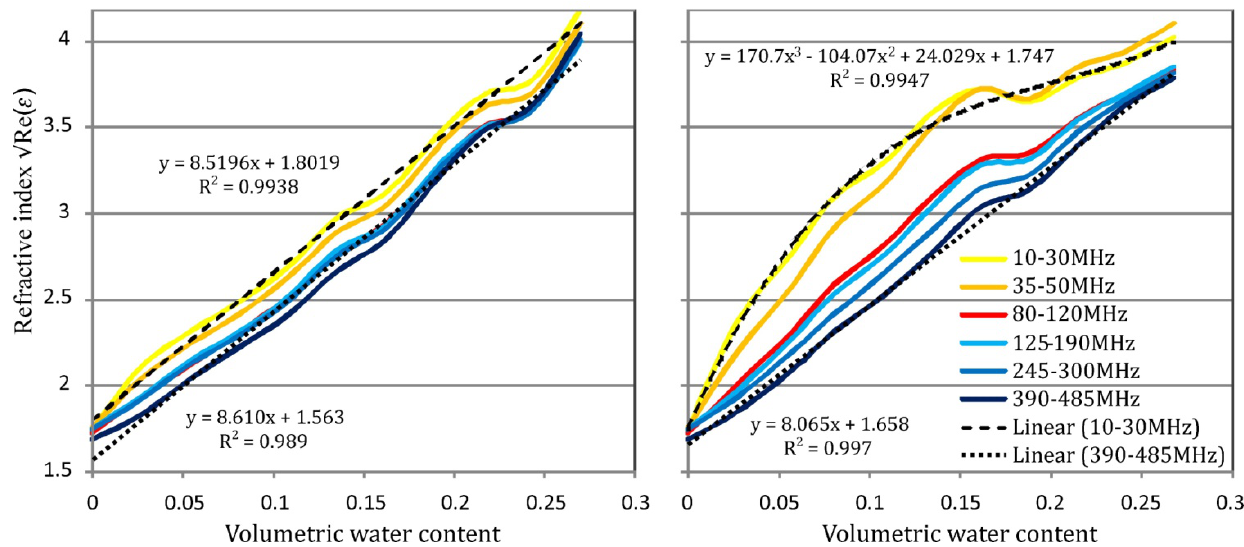
Figure 12. The influence of the measured frequency range on the value of the soil refractive index for the samples of soil 529 wetted with distilled water (left-hand graph) and 20 dSm –1 KCL solution (right-hand